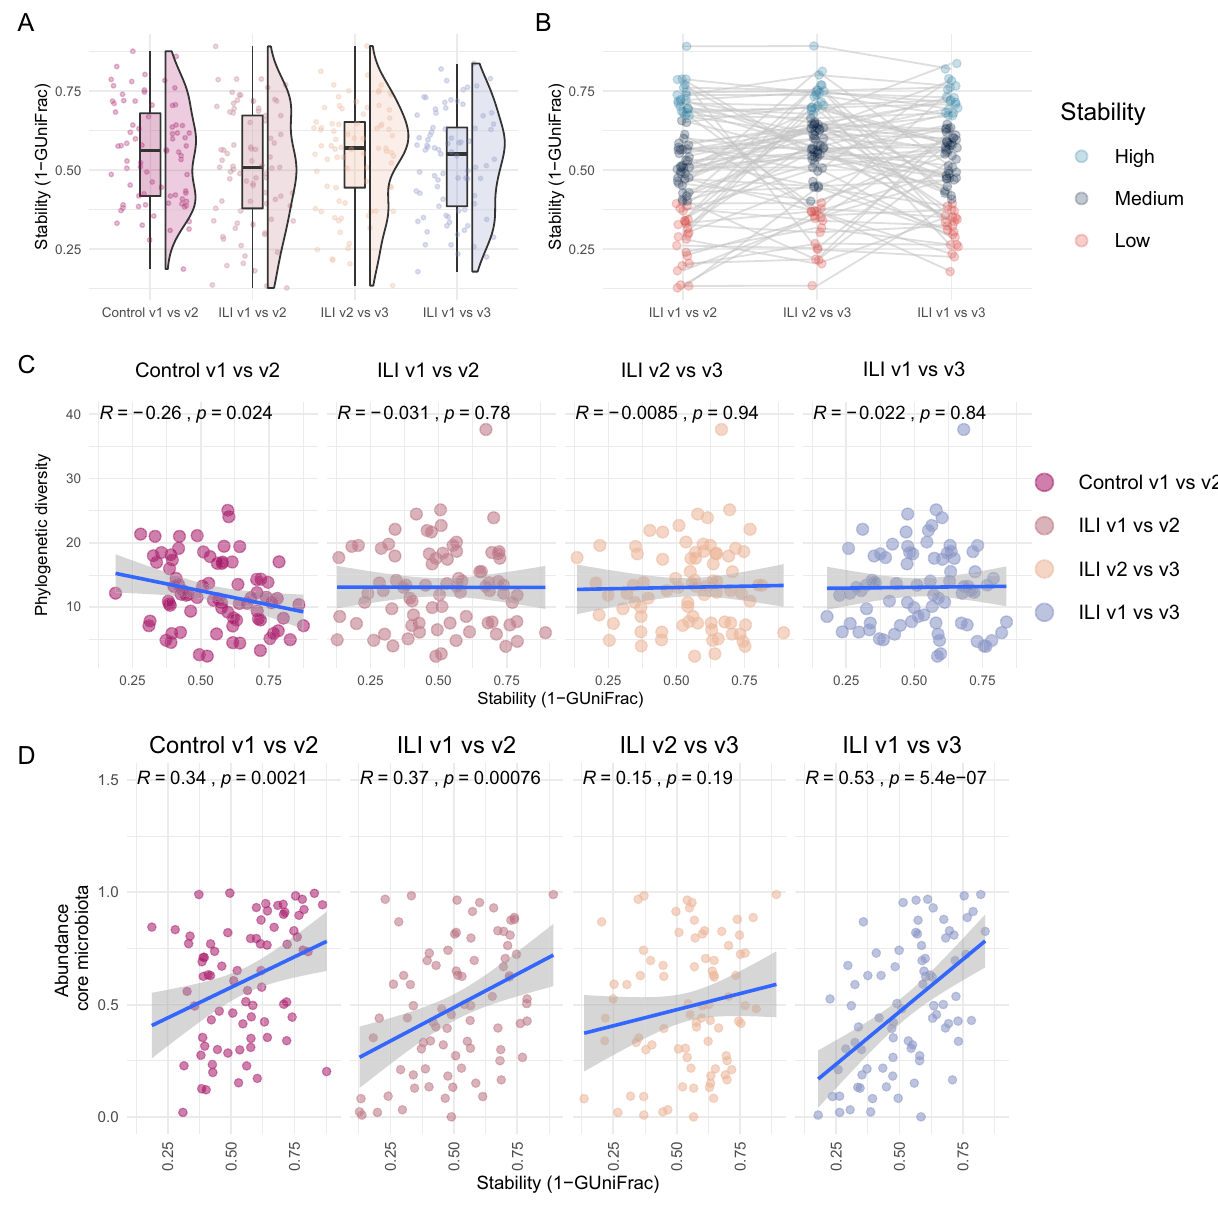
Figure 5. Associations of stability and diversity. ( A ) Comparison of microbiota stability between visits. Here for control group, visits are randomly carried out throughout the influenza season, with 14 days intervals between first (v1) and second (V2) visit. For the ILI group, v1 is the acute-phase of ILI, v2 is 14 days later and v3 is visit between 7 and 9 weeks after v1. ( B ) Depicts individuals categorized into three groups based on the stability of microbiota between visits. Each line connects observations for an individual to demonstrate differences between visits. ( C ) Spearman’s correlation between stability (1-GUniFrac) and Phylogenetic diversity. ( D ) Spearman’s correlation between stability (1-GUniFrac) and relative abundance of core